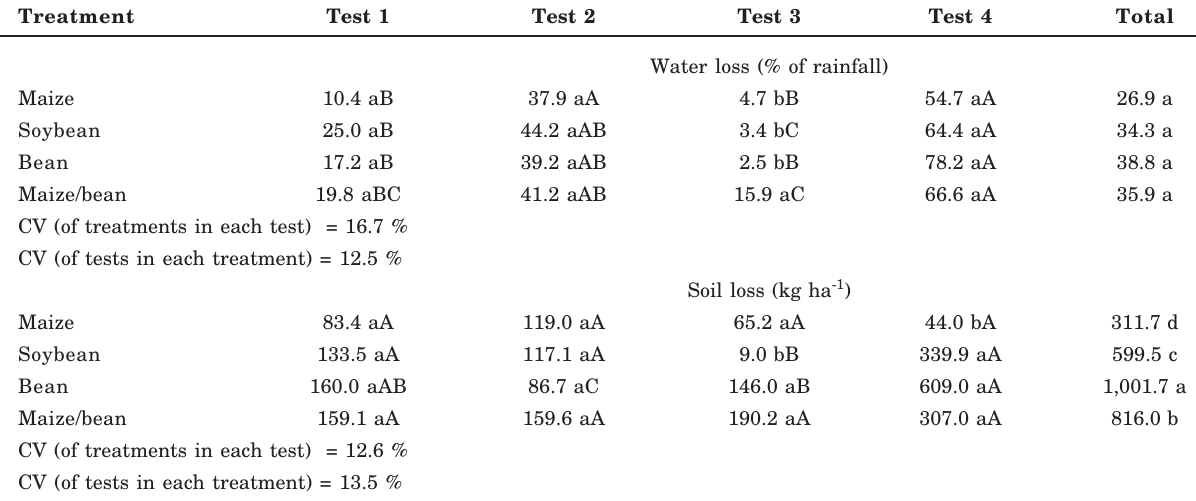
CV: coefficient of variation. Capital letters compare rainfall tests in each treatment, and small letters compare treatments in each rainfall test